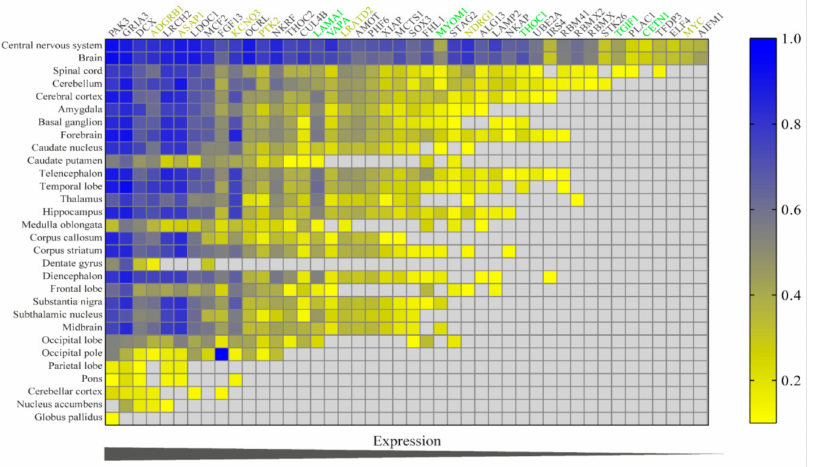
Figure 4. Heat map of expression of the 44 prioritized genes in CNS. Confidence value is calculated between 0–1.